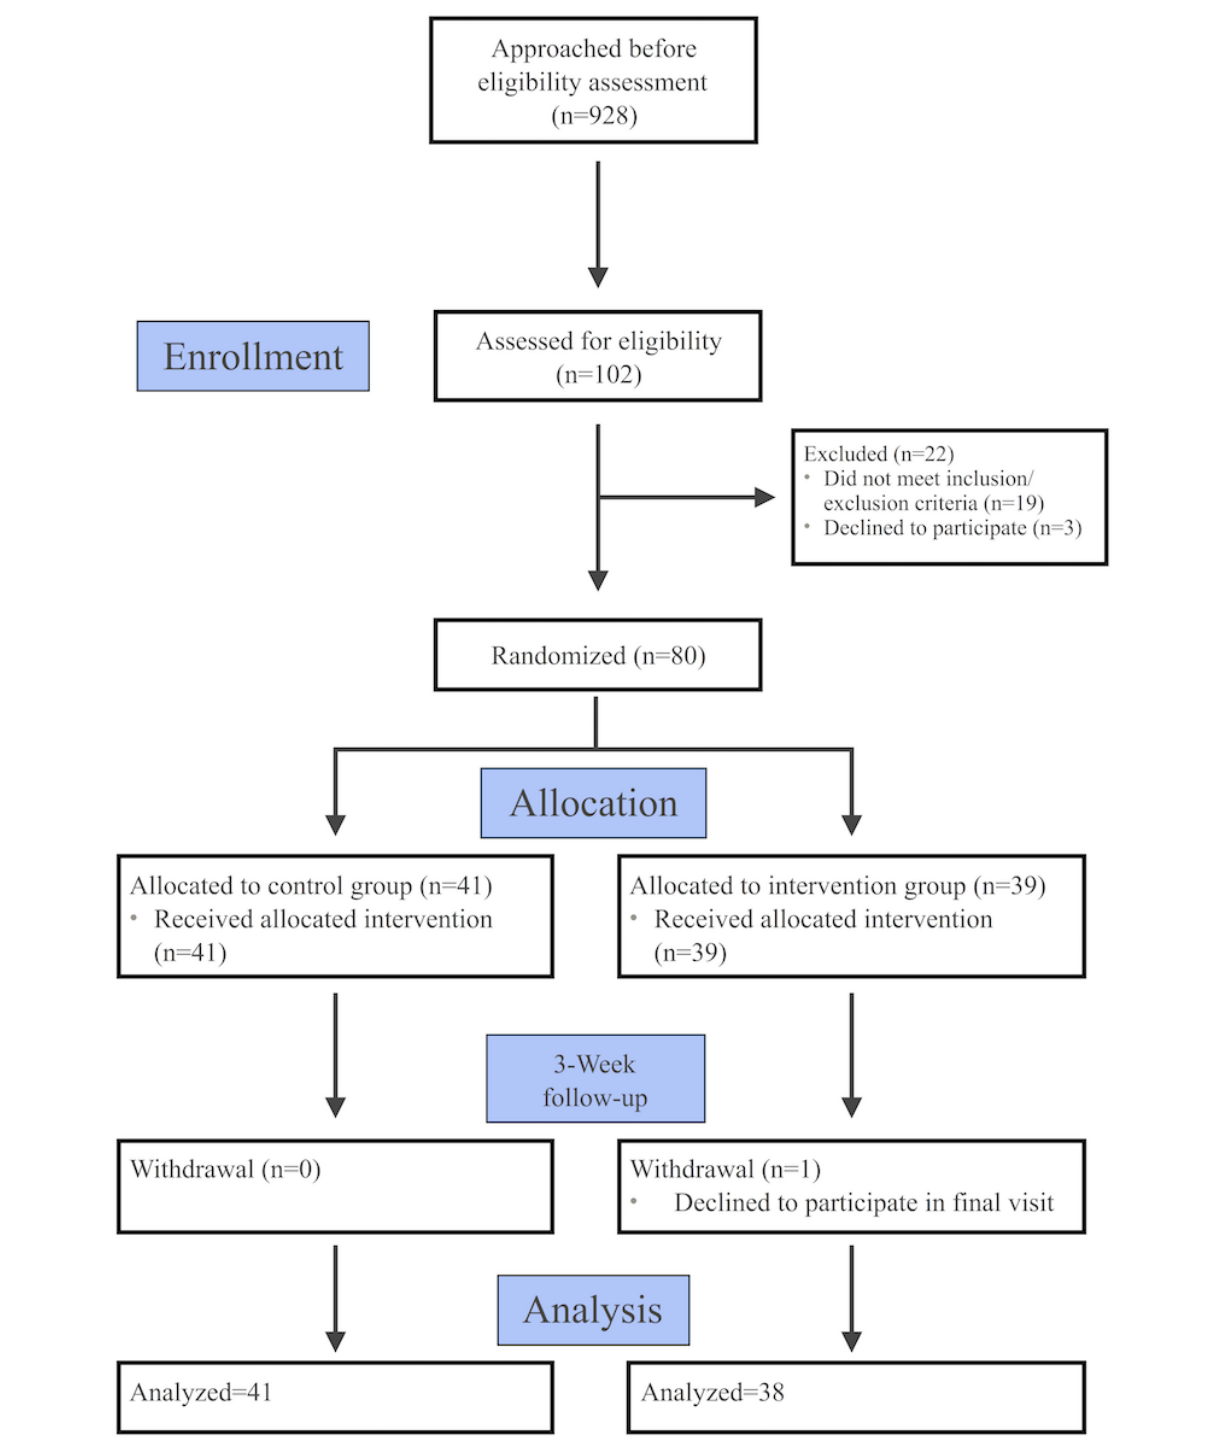
Figure 1. Consolidated Standards of Reporting Trials flow